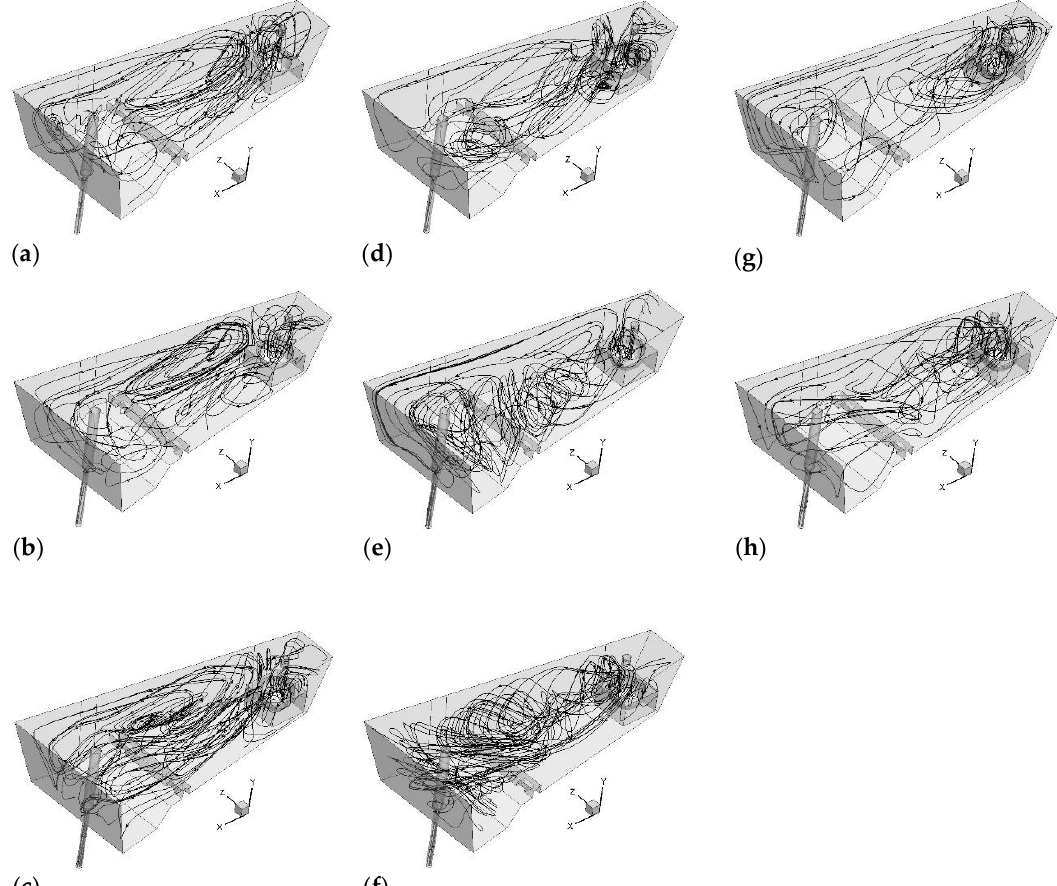
Figure 4. Liquid steel paths in the internal working volume of tundish for steady position of subflux turbulence controller: ( a ) case No. 12, ( b ) case No. 13, ( c ) case No. 14, ( d ) case No. 15, ( e ) case No. 16, ( f ) case No. 17, ( g ) case No. 18, and ( h ) case No. 19.